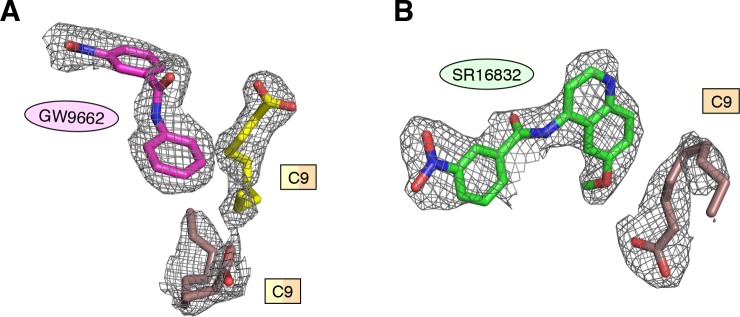
Omit map (2FO–FC, contoured at 1 σ) of the ligands in the (A) GW9662-bound and (B) SR16832-bound crystal structures of PPARγ LBD with cobound bacterial C9 ligands.